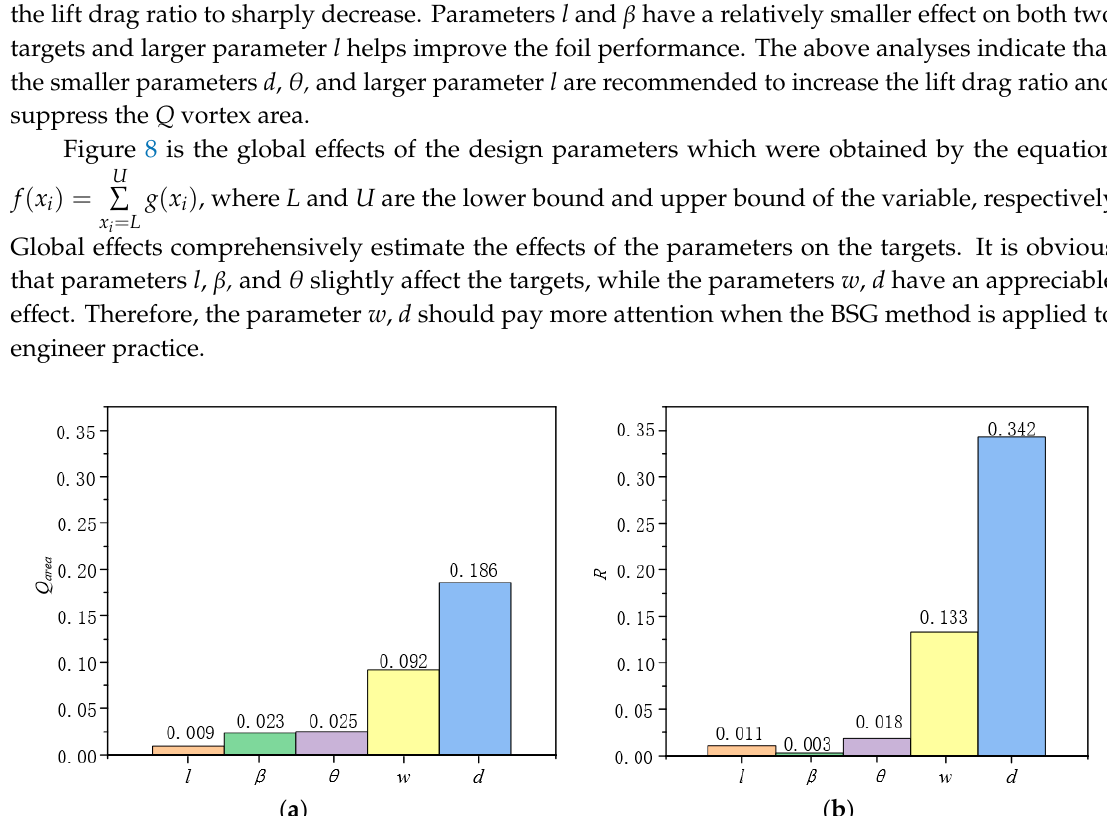
Figure 8. Global effects of design parameters. ( a ) Q votex isosurface(Q area = 2×10 7 ), ( b ) lift drag ratio. Figure 8. Global e ff ects of design parameters. ( a ) Q votex isosurface(Q